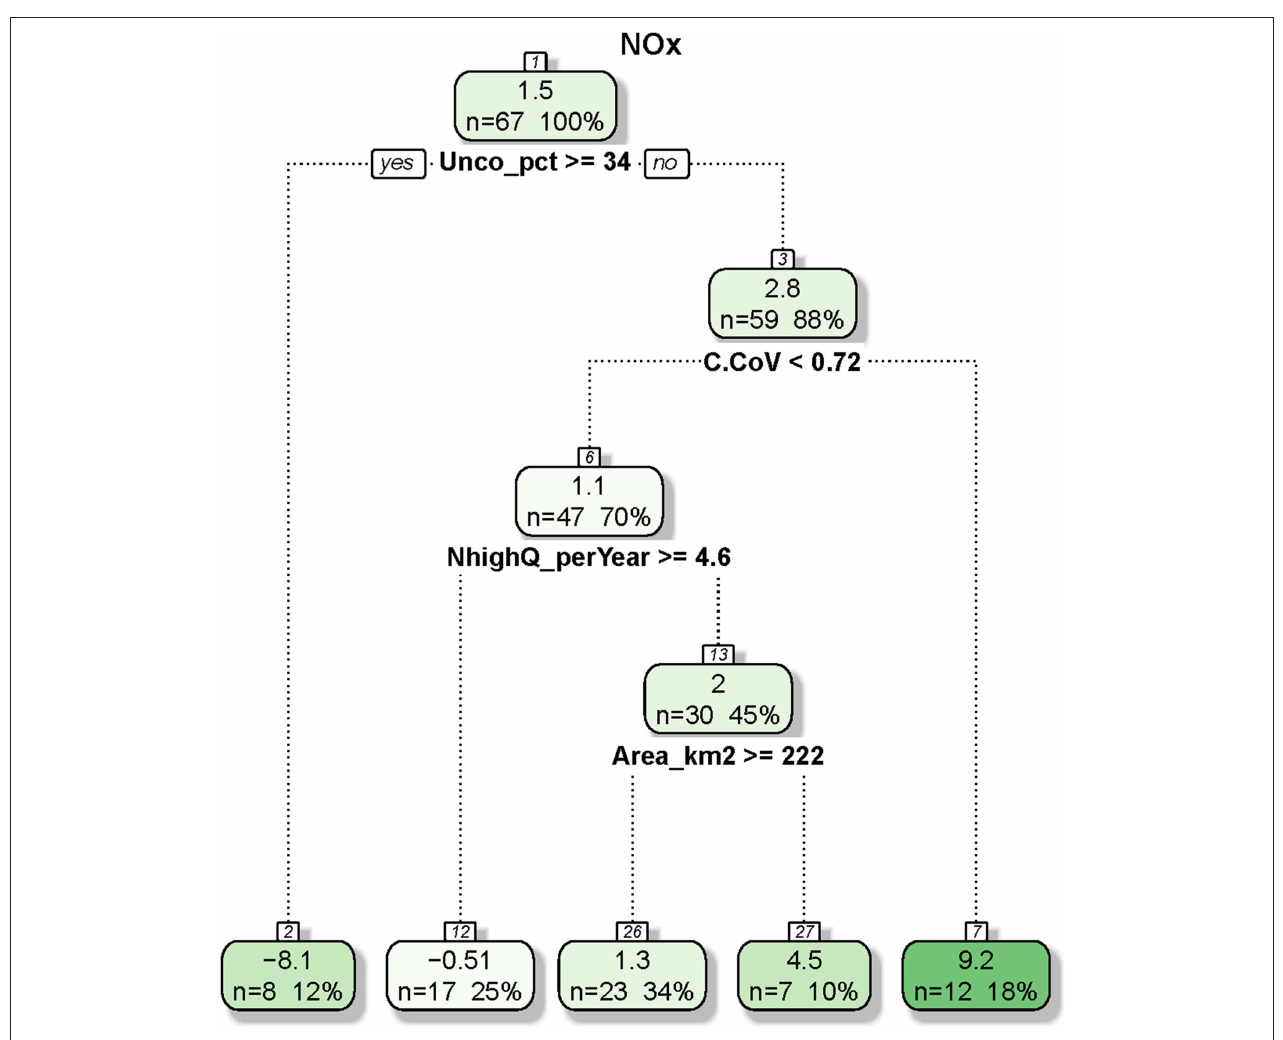
FIGURE 6 | Regression and classification tree developed for constituent flux bias for nitrate-plus-nitrite (NO x ). In each node, the top number represents the average bias (percent) of cases and the bottom numbers represent the number of cases and the percentage of cases (in bracket). Of the 68 cases for NO x , one was excluded due to missing values in land use and/or geology